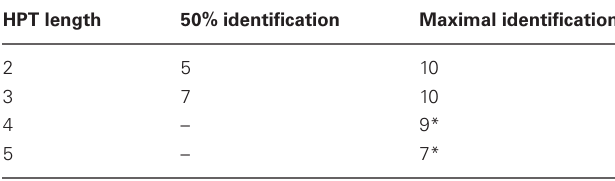
Table 5 | The numbers of sequences sharing an indel within a clone that are required in order for it to be considered legitimate, that allow the indicated level of artifact indel